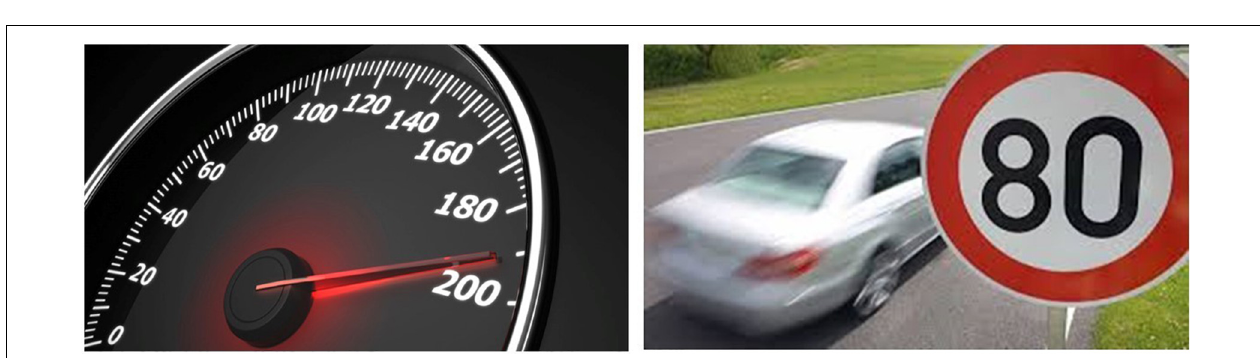
FIGURE 4 | Healthy and unhealthy food. Available at: https://www.freepik.com/free-photo/assortment-healthy-unhealthy-food_5200655.htm.